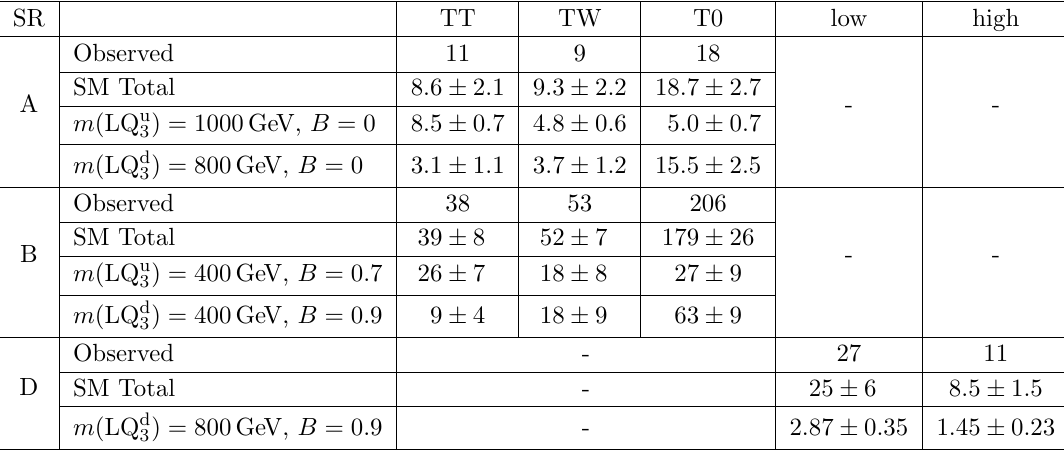
Table 5 . Number of observed events in SRA, SRB, and SRD, together with the number of (cid:12)tted background events including their total uncertainty, taken from ref. [23] (CR background-only (cid:12)t). Additionally, the expected number of signal events for di(cid:11)erent branching ratios and LQ masses close to the exclusion limits are given with statistical uncertainties.